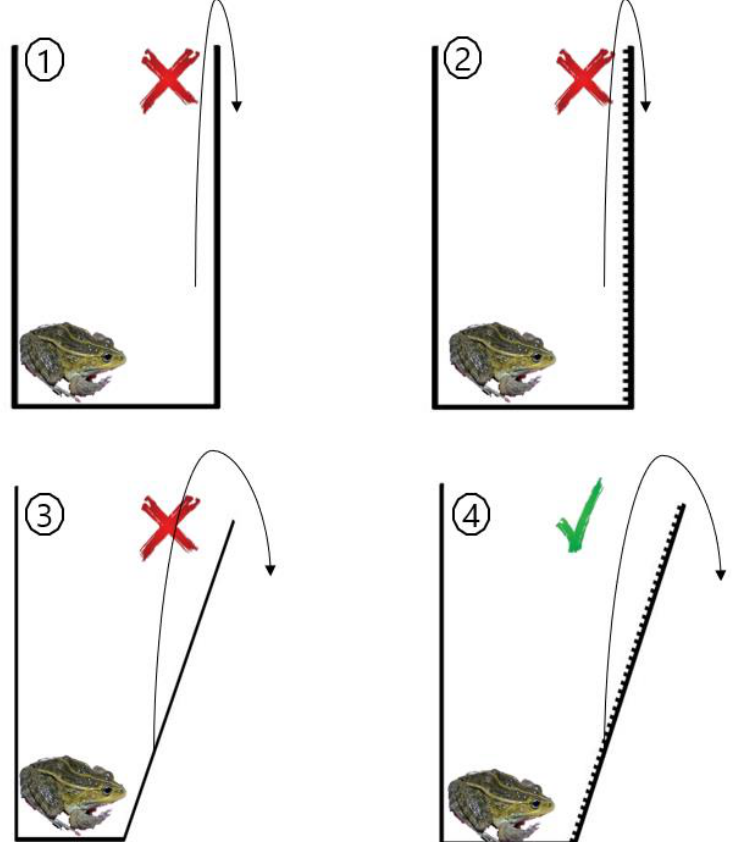
Figure 1. Experimental design for the escape trials. We used for ditch types: ( 1 ) 90° angle and no engraved patterns, ( 2 ) 90° angle with engraved patterns, ( 3 ) 70° angle towards the external side and no engraved patterns and ( 4 ) 70° angle towards the external side and engraved patterns. We used Pelophylax nigromaculatus for the trials, as a representative species for anurans in general.